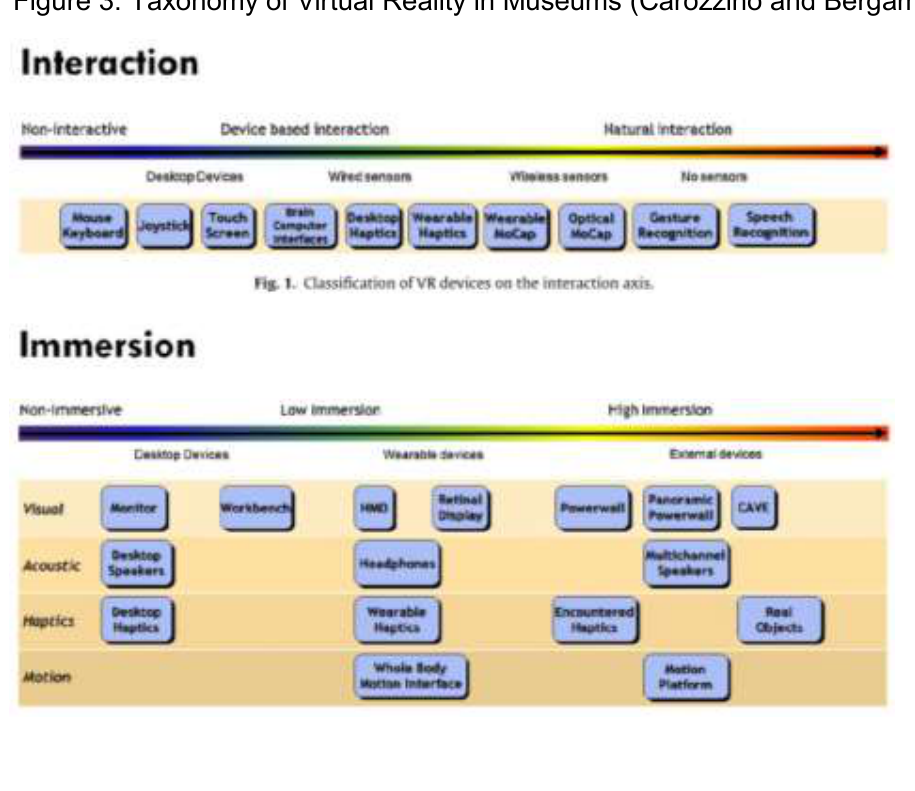
Figure 3. Taxonomy of Virtual Reality in Museums (Carozzino and Bergamasco,